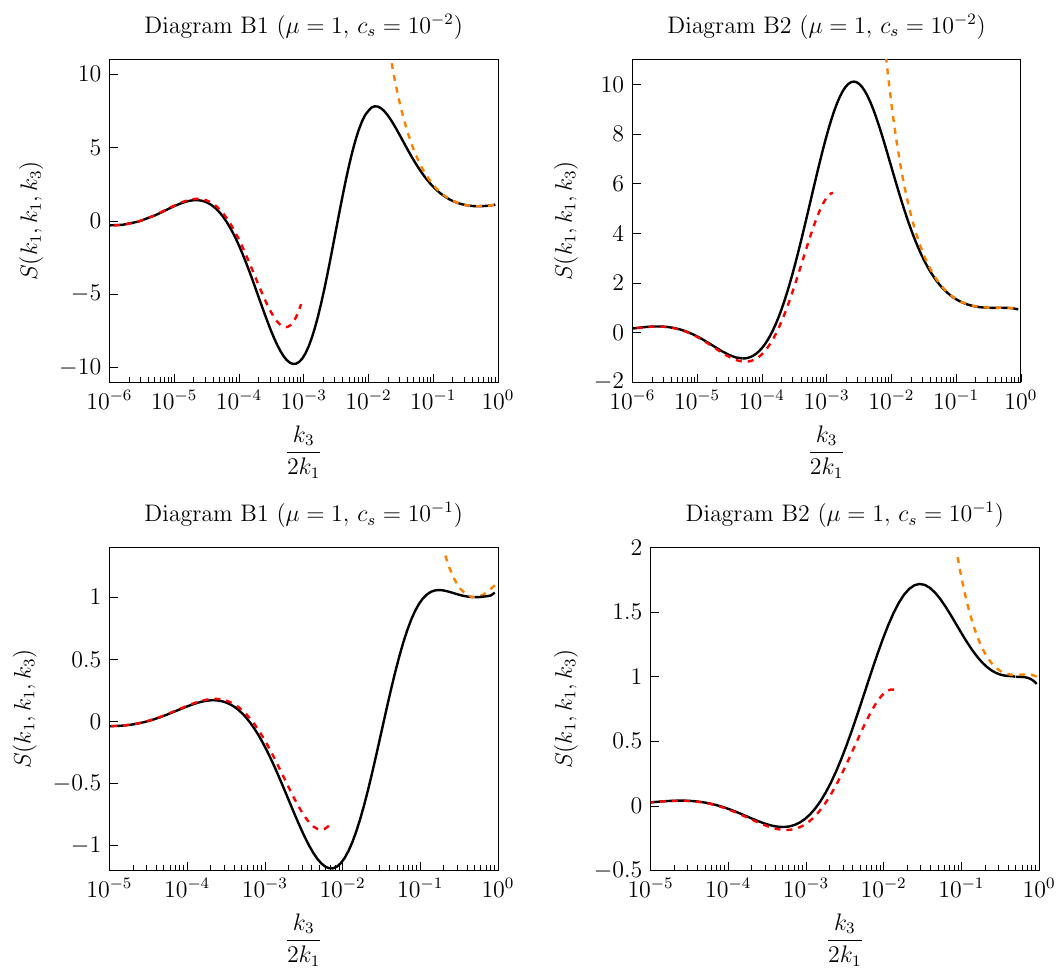
Figure 11 . Shapes S ( k 1 , k 1 , k 3 ) of the bispectra for isosceles triangles, normalized to unity in equilateral configurations, for diagrams B1 (left) and B2 (right), and for ( µ = 1 , c and ( µ = 1 , c = 0 . 1) (bottom). The dashed red and orange curves represent respectively the s ultra-squeezed (5.12) and the low speed signals